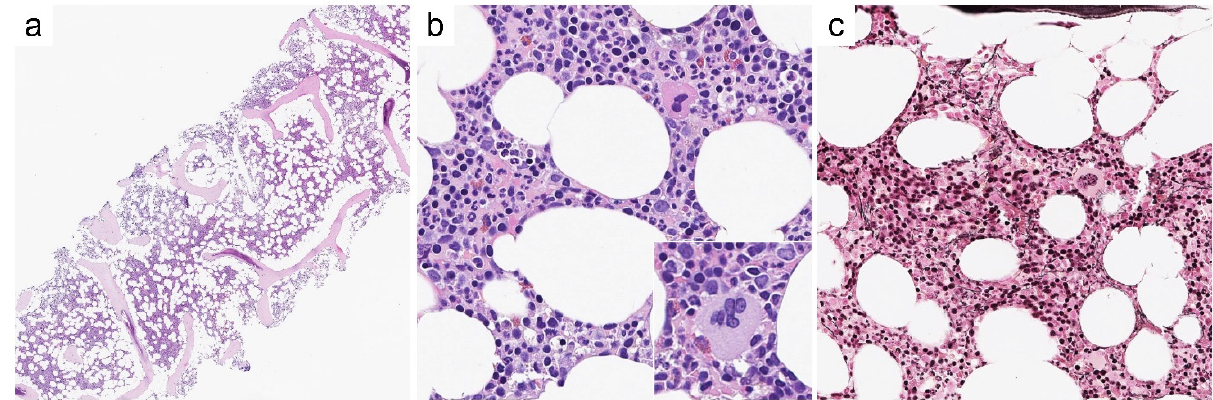
Figure 2. Representative histological features of case #1. BM biopsy shows cellularity within normal limits ( a ; H/E, 20×) with accumulation of hematopoiesis in central marrow spaces and marginalization of the adipose tissue close to the bony trabeculae. Maturation of erythroid and myeloid lineages is preserved ( b ; H/E, 200×), but scattered, large megakaryocytes are noted ( b , inset ). Reticulin network is unremarkable ( c , Gomori silver stain, 200×).